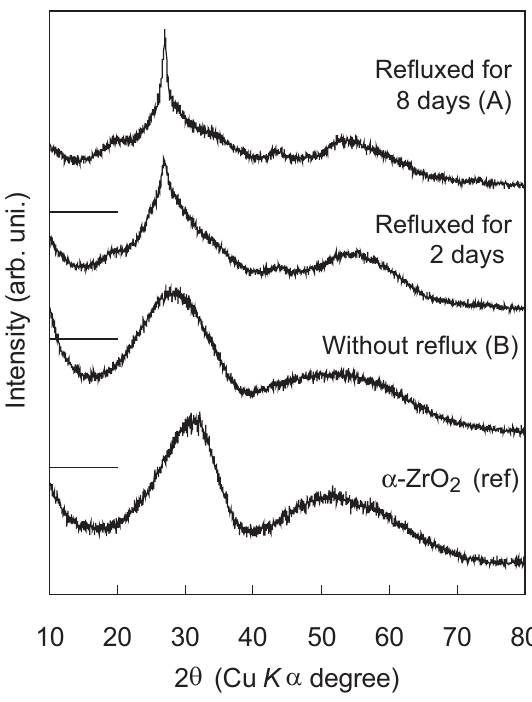
Figure 1. X-ray diffraction patterns of ZrSiO 4 gel sam- ples; refluxed for 8 days ( top ), refluxed 2 days ( middle ), and condensed without refluxing ( bottom ). The pattern of amorphous ZrO 2 is also given for comparison ( ref ).